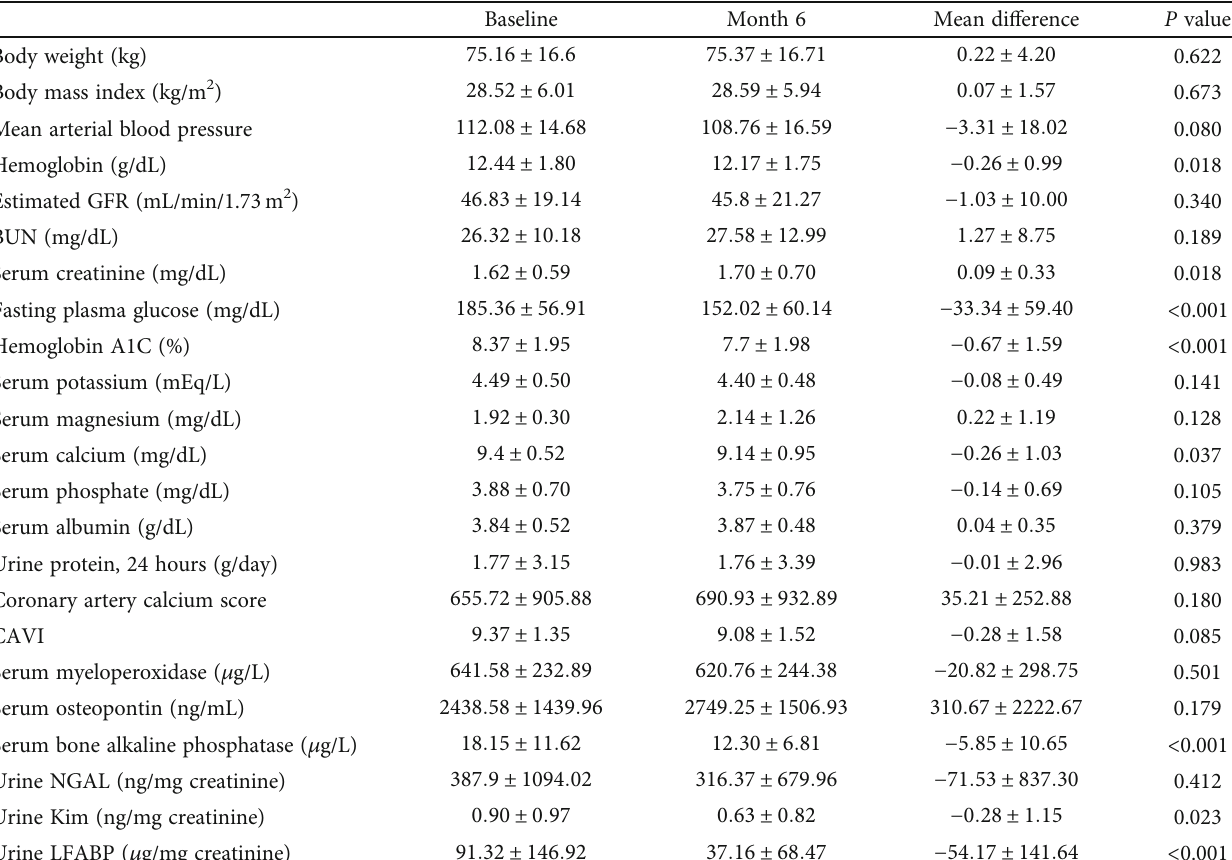
Table 2: Changes in clinical characteristics and laboratory indices in the gemigliptin group from baseline to month 6.